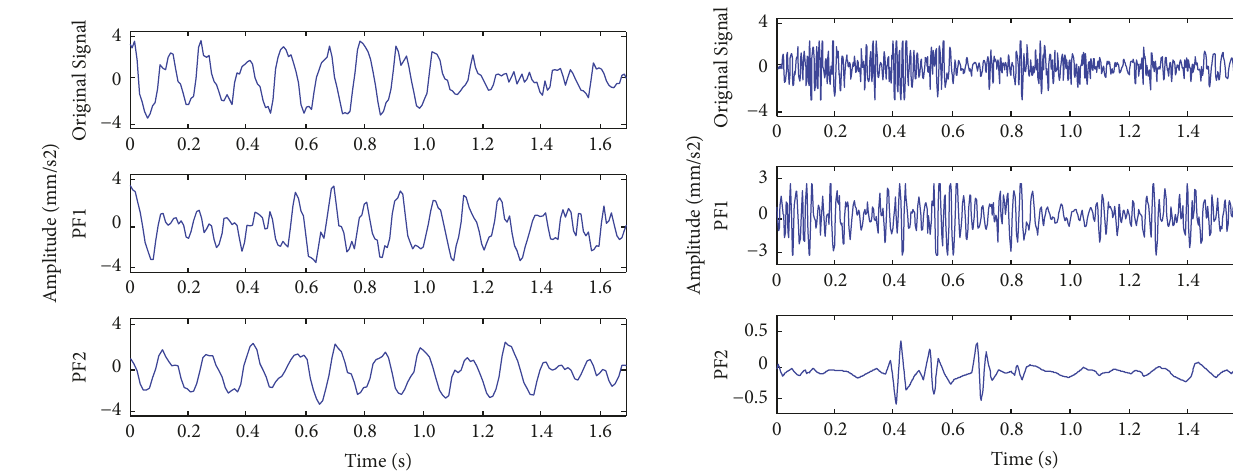
Figure 12: LMD results of inner circle fault signal.